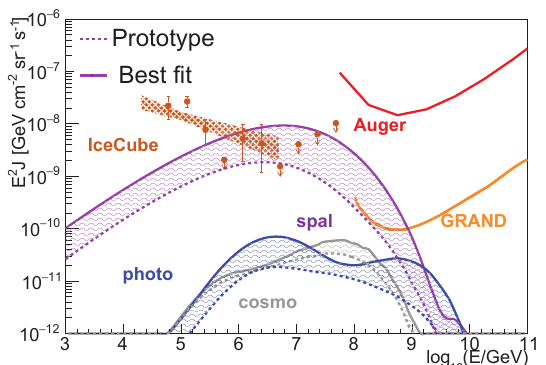
Figure 6. Single-flavour neutrino fluxes for the prototype case (dashed) and best case (solid), compared to the IceCube neutrino flux (both High Energy Starting Events [41] (points) and single power-law flux from muon-neutrinos [42] (band)), the expected sensitivity of GRAND after three years of operation [40] and to the limits for the cosmogenic neutrinos by the Pierre Auger Col- laboration [39]. The shaded area is drawn in order to highlight the di ff